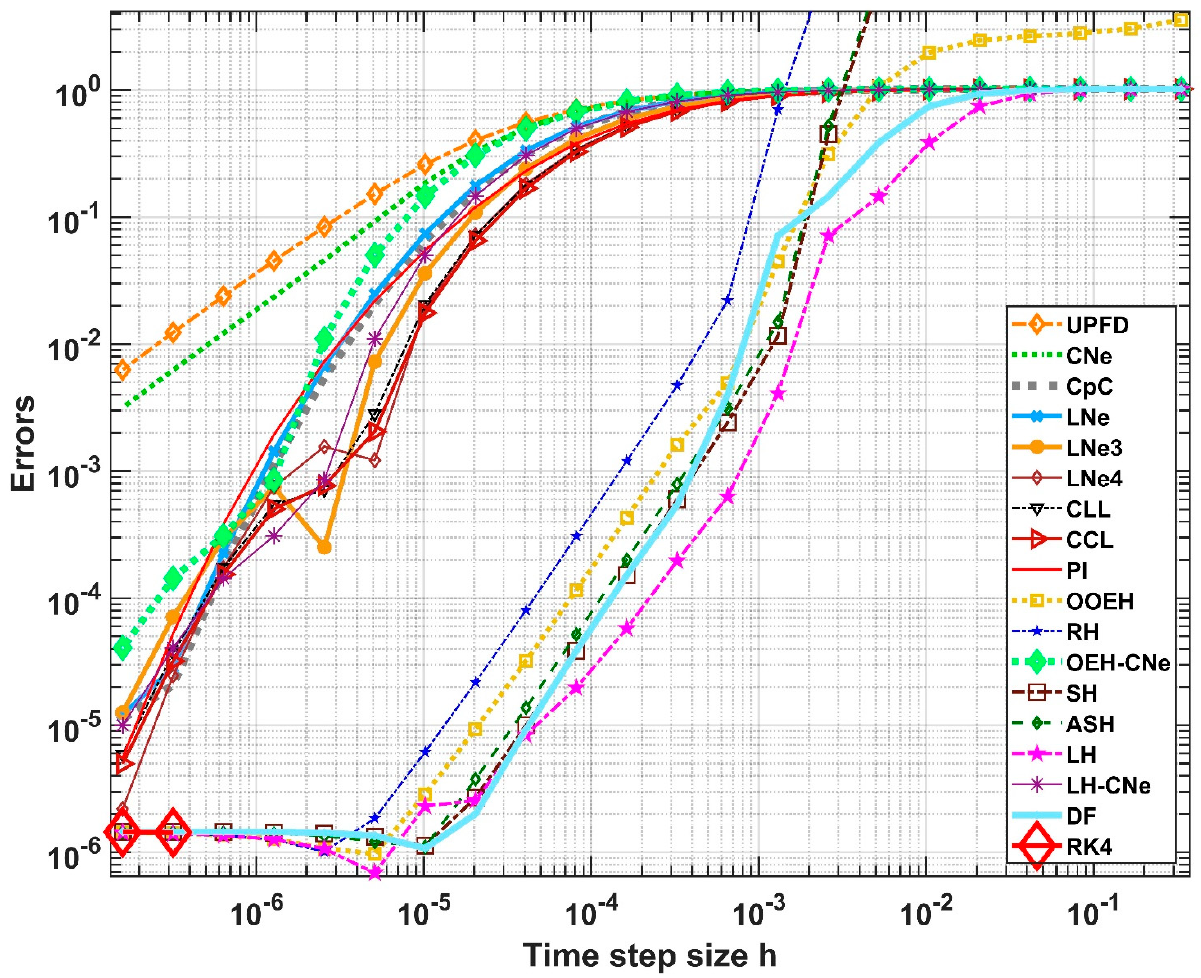
Figure 5. Maximum errors as a function of the time-step size for Experiment 1. The numerical order of convergence of the algorithms are the slopes of the error curves.